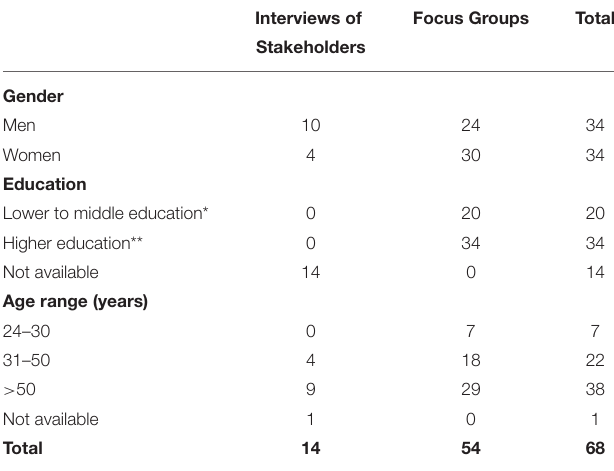
TABLE 1 | Characteristics of the